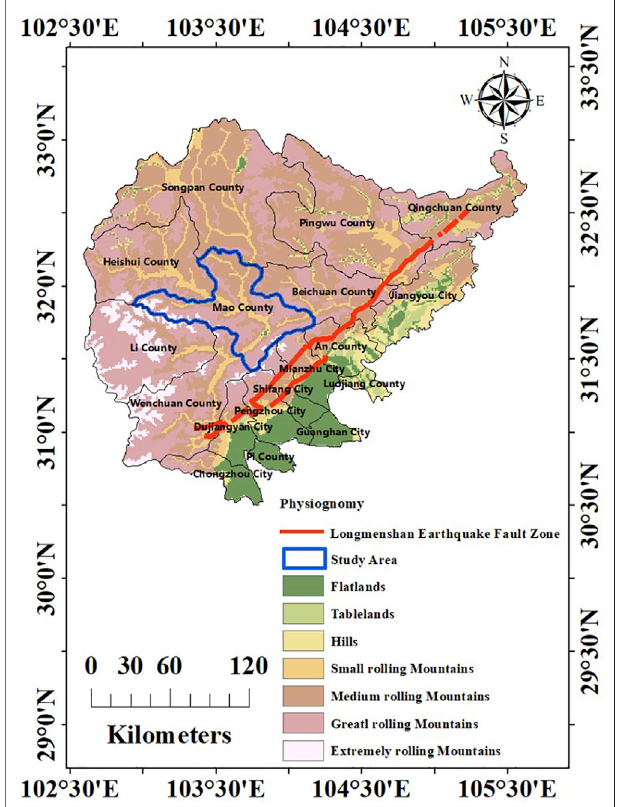
FIGURE 2 | Longmenshan fault